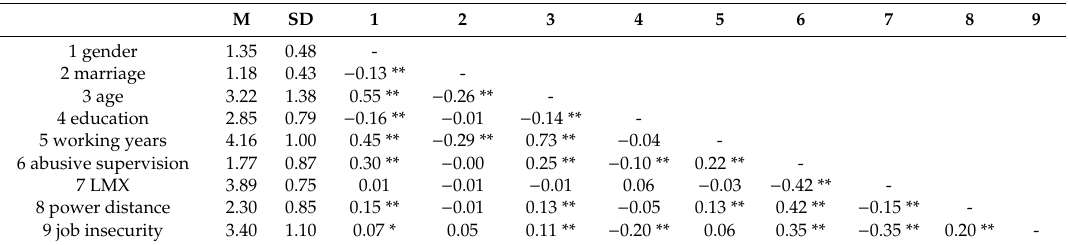
Table 2. Scale descriptive statistics and Pearson correlations among study variables (N = 936).